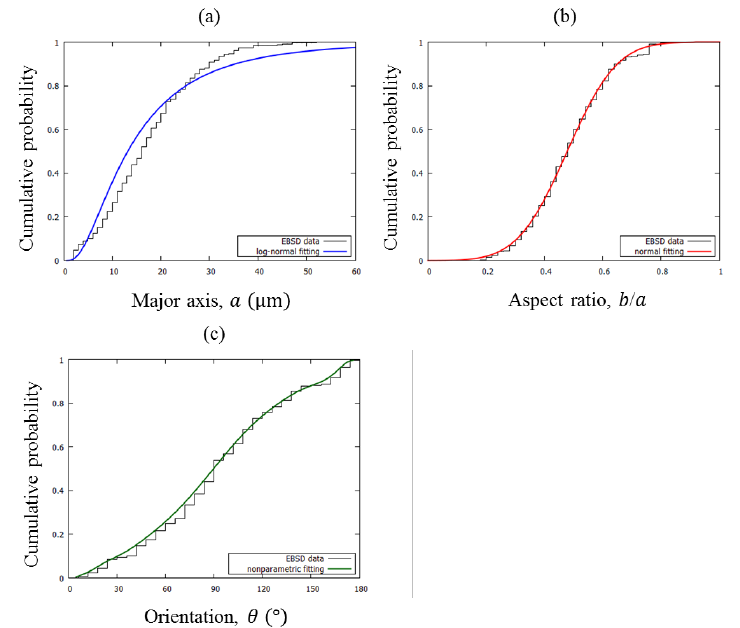
Figure 3. Cumulative distribution functions of ( a ) major axis, ( b ) aspect ratio, and ( c ) orientation for ferrite of S25C steel.